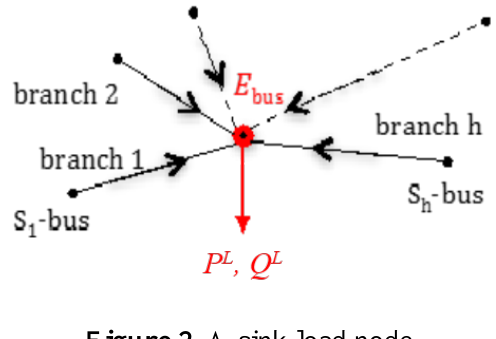
Figure 2. A sink load